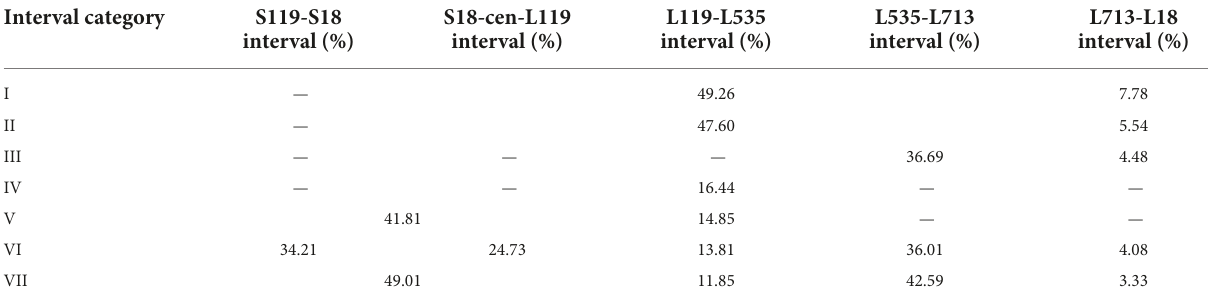
TABLE 3 Recombination frequencies of 5A chromosome in each intervals in F 2 population from seven F 1 categories (I–VII)*. Interval category